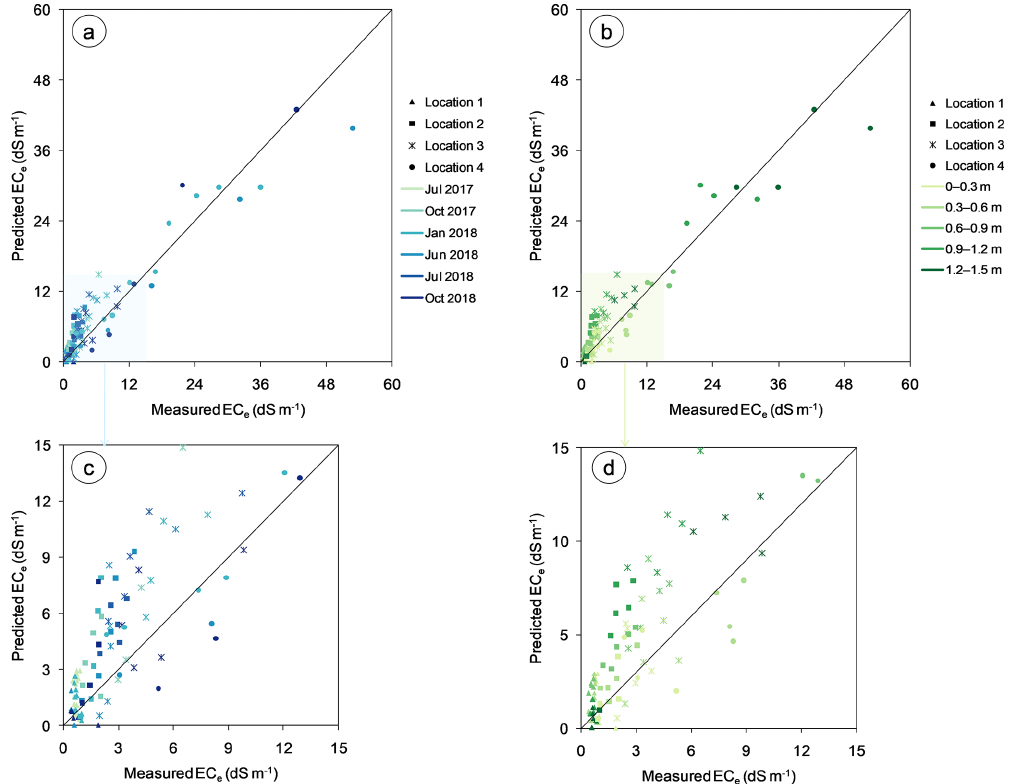
Figure 5. Plots of predicted EC e versus measured EC e and the 1 : 1 line, obtained for locations 1 to 4, identified in terms of date of measurement (a) and depth of measurement (b) . Plots (c) and (d) show enlargements of the lower left parts of plots (a) and (b) , respectively.